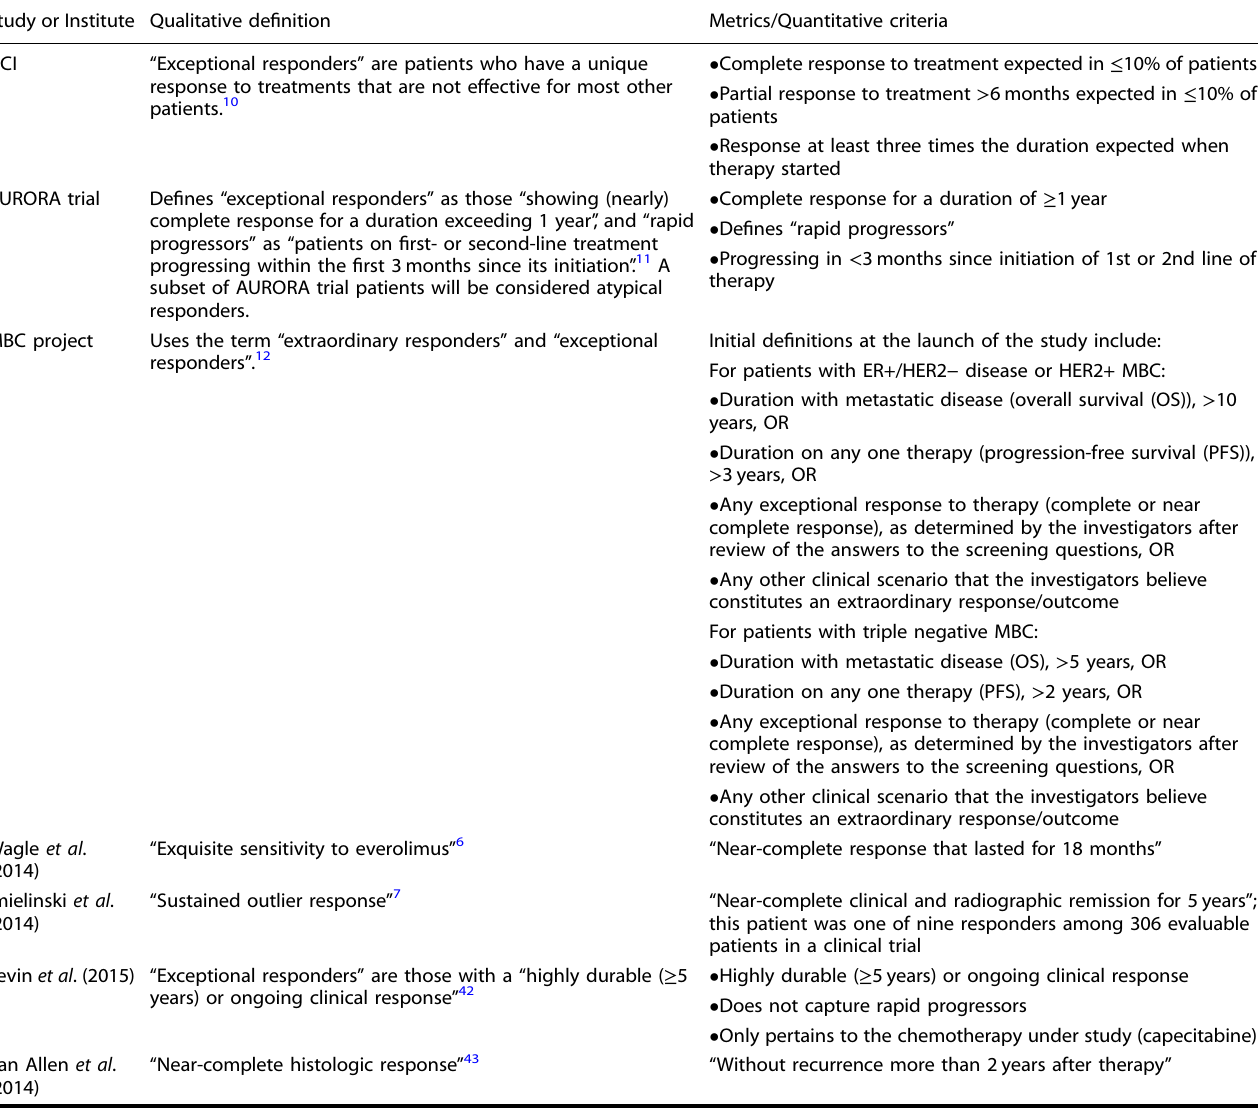
Table 1. Current initiatives and published studies examining an atypical response Study or Institute Qualitative de fi nition Metrics/Quantitative criteria